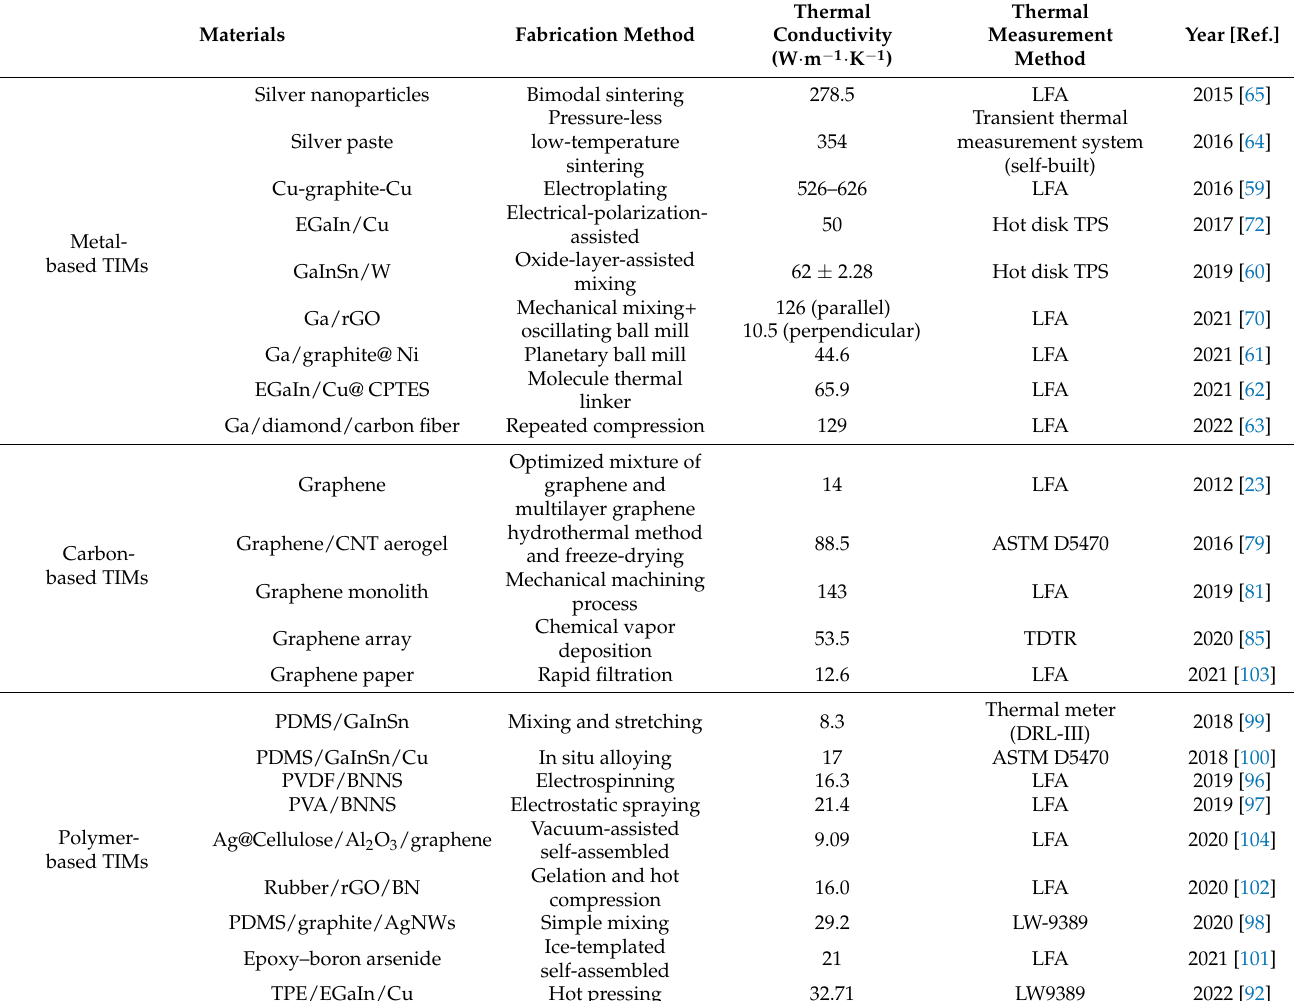
Table 2. A summary of fabrication methods and thermal performances of recently developed advanced thermal interface